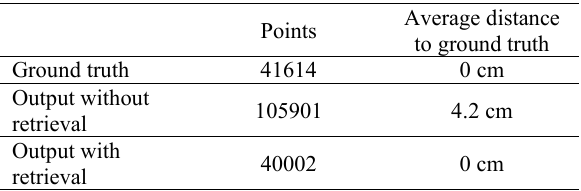
Table 2 . Comparison between ground truth, output of the point based mathematical opening and the proposed method in terms of number of points and average distances to the nearest point of the ground truth data.